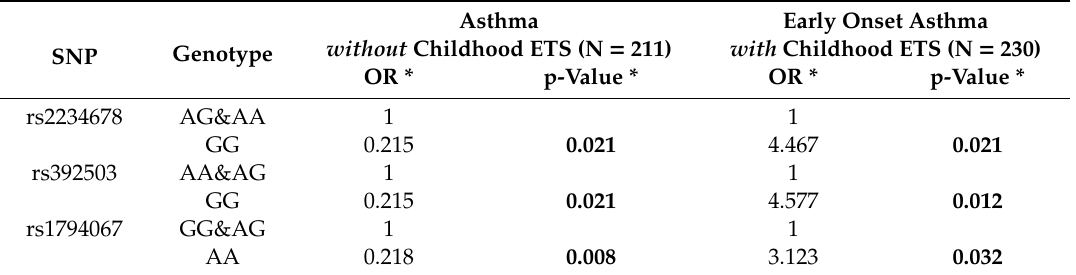
Table 3. Genotypic association for asthma and early onset asthma stratified by childhood ETS. Asthma Early Onset Asthma without Childhood ETS (N = 211) with Childhood ETS (N = 230) SNP Genotype OR * p-Value * OR